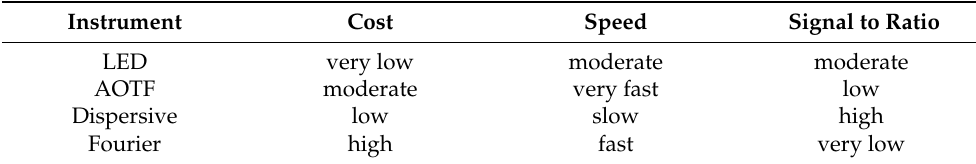
Figure 1. ( a ) Transmittance measurement mode, which is used with gases and semi-solids placed in a cuvette; ( b ) transflectance measurement mode, which is used with semi-solids without a cuvette; ( c ) diffuse reflectance measurement mode, which is used with solids where the measurement is taken from the NIR incidence; ( d ) transmittance through a scattering medium. Table 1. Comparison of different NIR